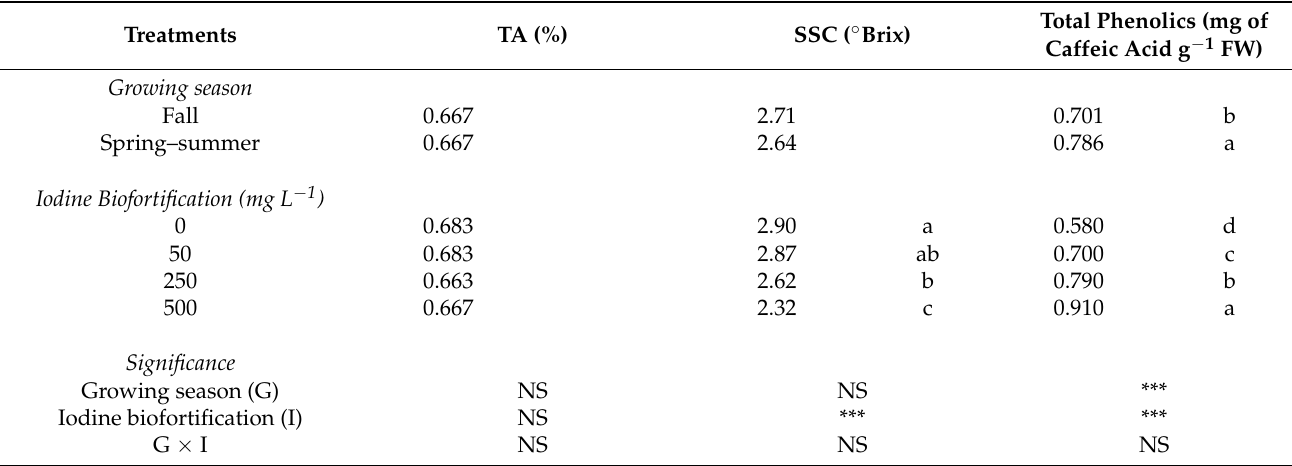
Table 2. Effect of growing season (fall or spring–summer) and iodine biofortification supply (0, 50, 250 or 500 mg L − 1 ) on TA, SSC, and total phenolics of curly endive.